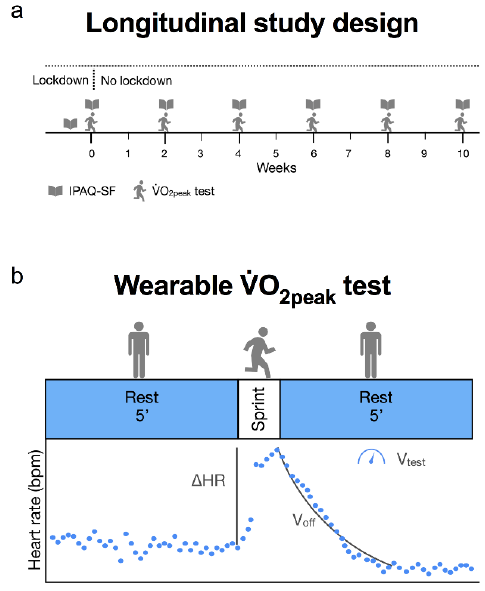
Figure 1. ( a ) Exploratory longitudinal study design. Every two weeks, physical activity and cardiorespiratory fitness ( V̇ O 2peak ) were assessed through the International Physical Activity Level Questionnaire-Short Form (IPAQ-SF) and the 60 m sprint test, respectively. ( b ) Schematic representation of the protocol used to estimate V ̇ O 2peak [15]. A wearable device recorded the HR before, during, and after a 60-metre sprint run. The baseline-to-peak HR difference ( ∆ HR), the velocity of HR decay after the sprint (v off ), and the mean 60 m sprint speed (v test ) were used as predictors.